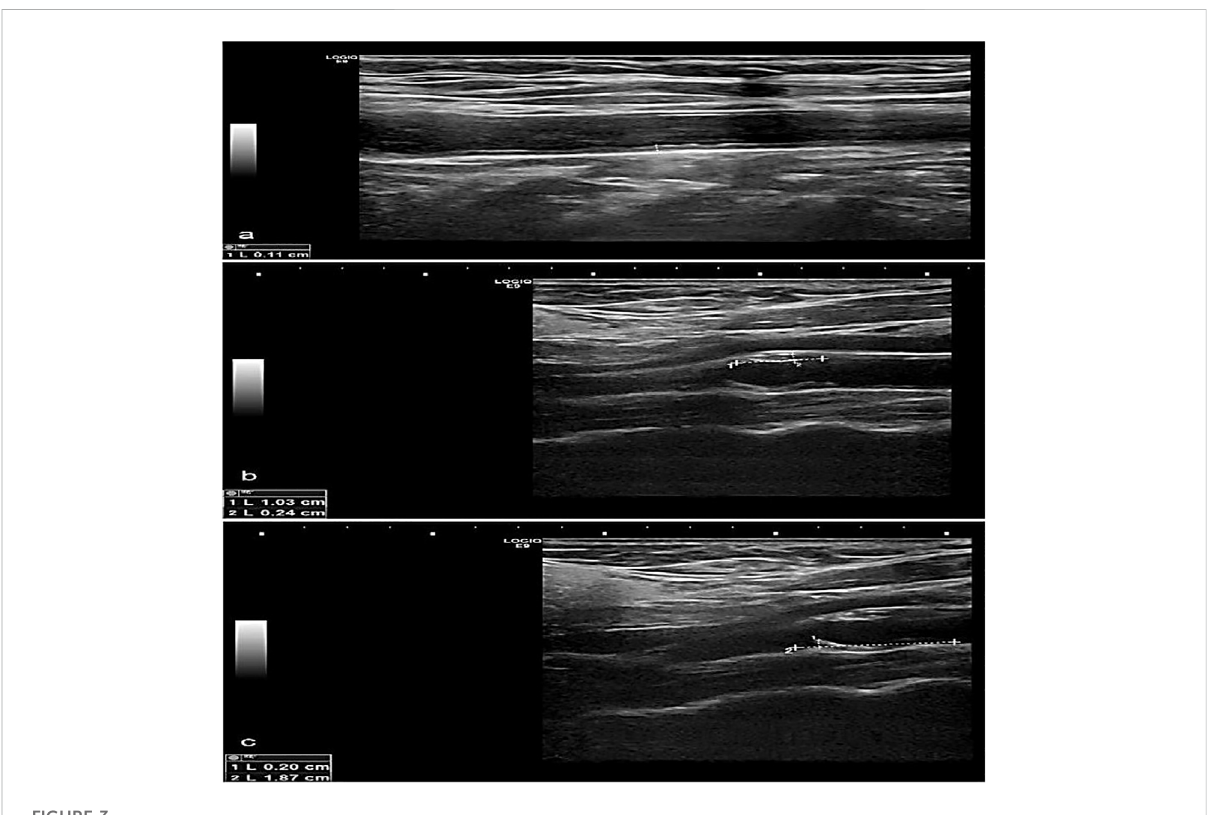
represents one of the primary causes of AIS in patients. Apoptosis in AIS can be in fl uenced by both downregulation and upregulation of a speci fi c ncRNA. TUG1 promotes apoptosis in neurons by sponging miR-9 and increasing Bcl2l11 expression